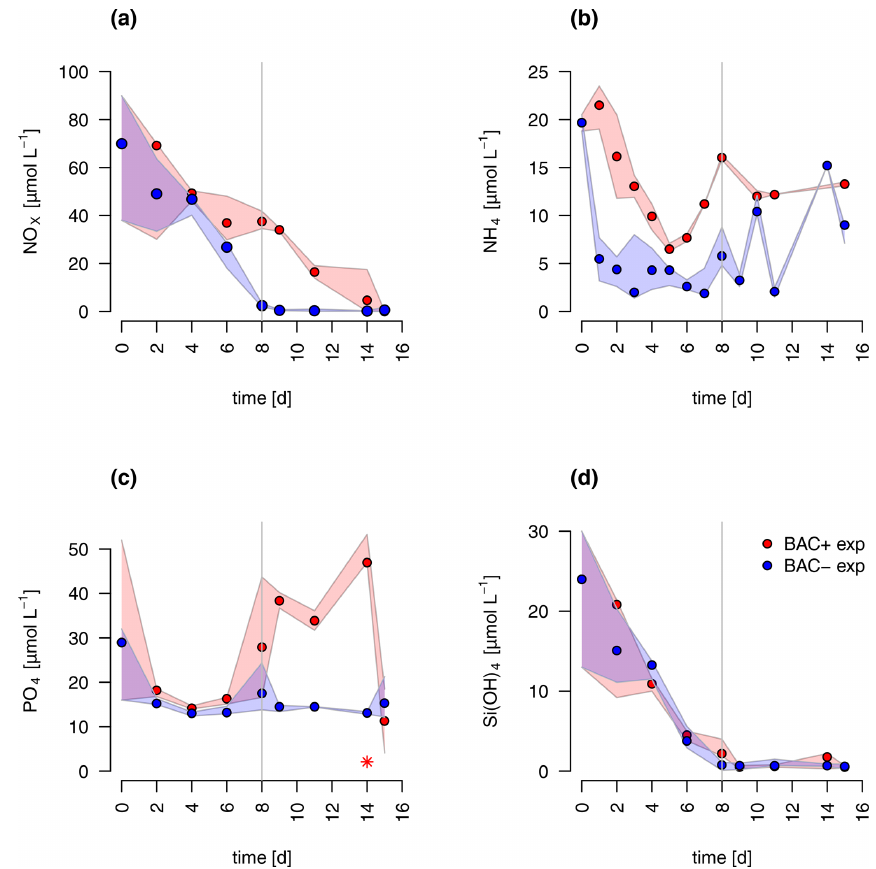
+ NO − ), (b) NH + , (c) PO 2 − (the asterisk indicates a 3 2 4 4